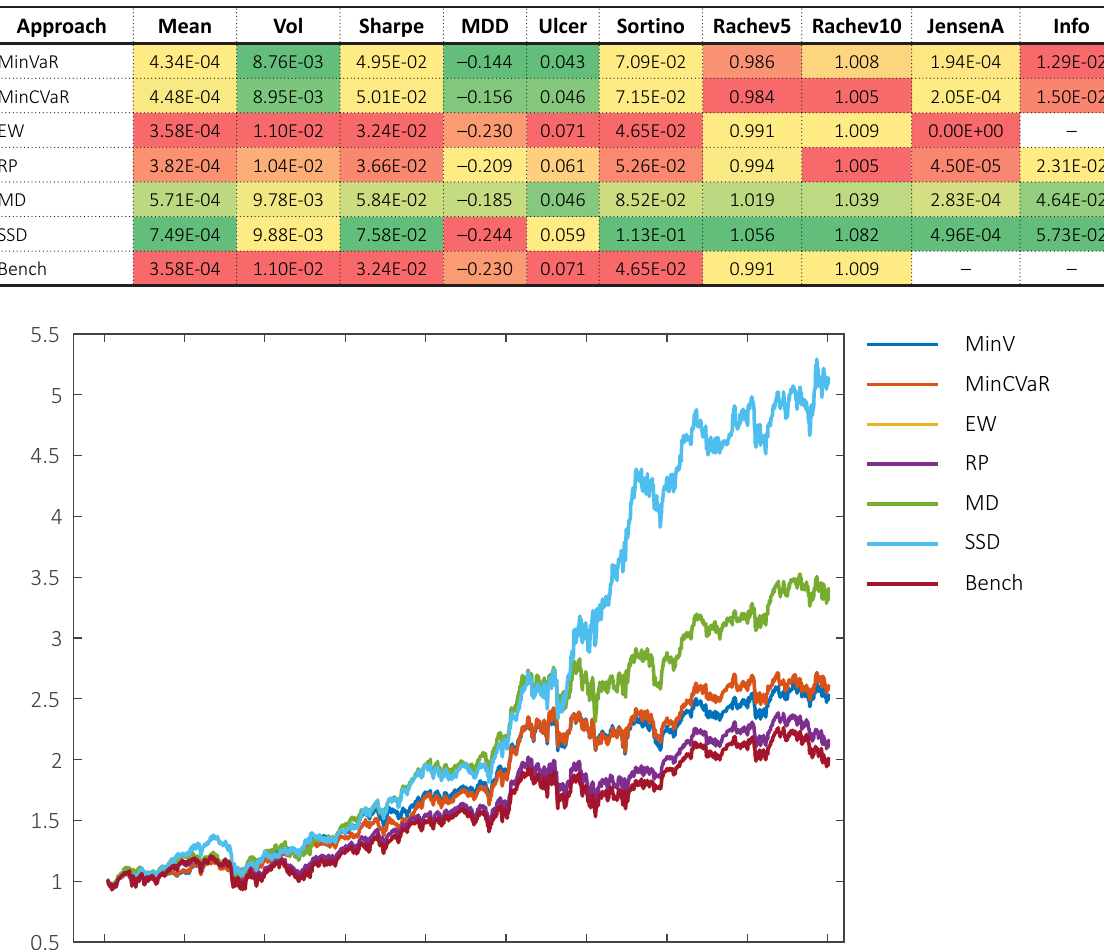
Table 3. Out-of-sample results without preselection Approach